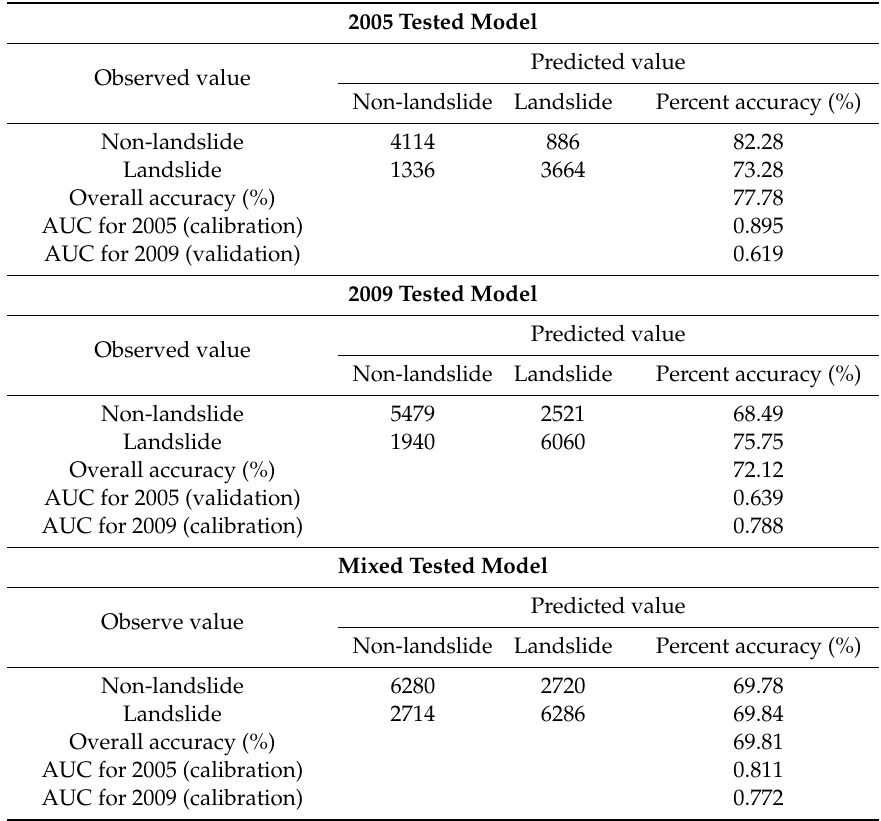
Table 4. Prediction accuracy of each